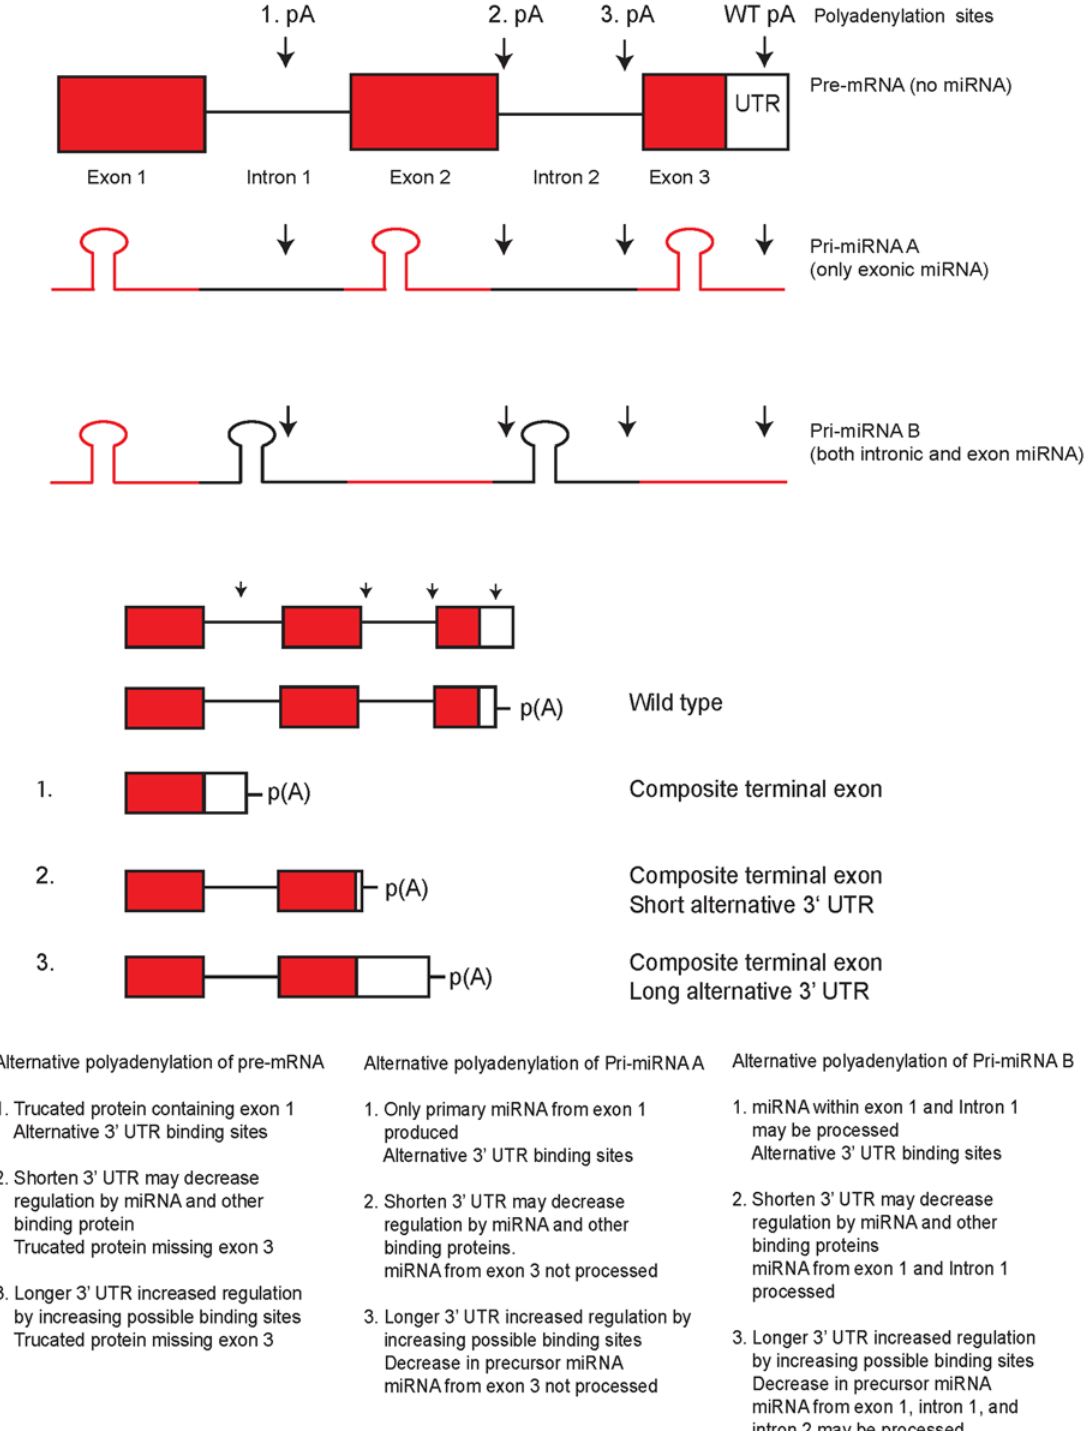
Fig 13. Model of miRNA regulation by alternative polyadenylation sites located within introns. Alternative polyadenylation causes a change in possible miRNA binding sites and truncation of mRNA. Polyadenylation that results in a shortening 3'-UTR generally lowers regulation by miRNA, while a lengthening 3'-UTR increases regulation by miRNA. Alternative polyadenylation of pri-miRNA affects the ability of miRNA to be produced by preventing miRNA stem loop regions from being processed. Alternative polyadenylation sites within the 3' UTR o f a transcripts can have a shorter or longer 3' UTRs. Alternative polyadenylation within introns sequences creates a transcript with an extended coding region that end at the first stop codon within an intron and also creates a 3' UTR. The alternative polyadenylation within an exon does not create a 3'-UTR region.